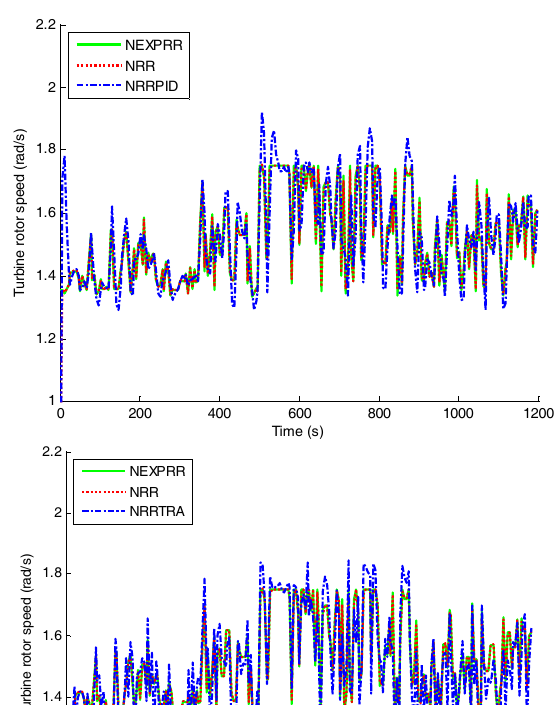
Figure 10. The turbine rotor speed.